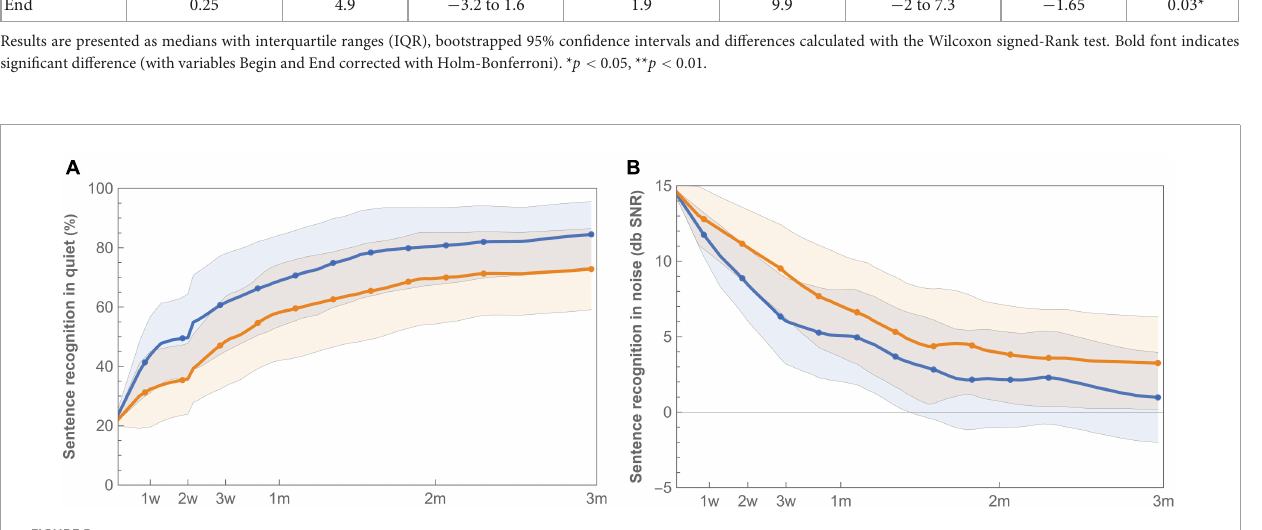
FIGURE5 Learning curves for mean sentence recognition in quiet (A) and noise (B) with imaging-based (orange − ) and standard (blue − ) fitting, which were worn according to a randomization schedule during the first 3 months of CI rehabilitation. Sentence recognition in quiet is presented as percent correct, while sentence recognition in noise is expressed as the Speech Reception Threshold (SRT), for which a lower value indicates better speech understanding. Error bands indicate 95% confidence intervals.